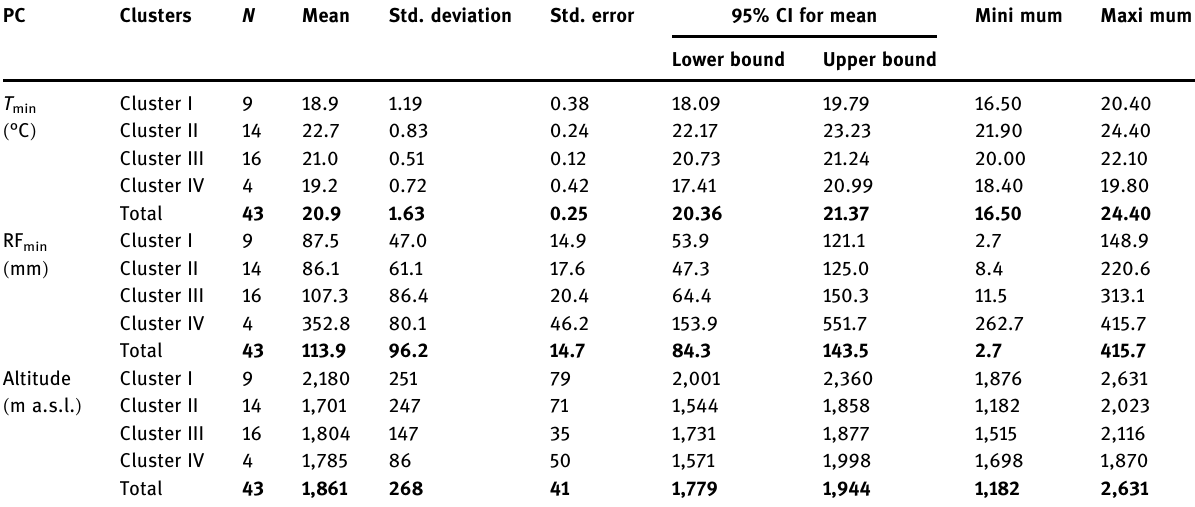
Table 6: Descriptive statistics for the most signi fi cant variables in FMAM season PC